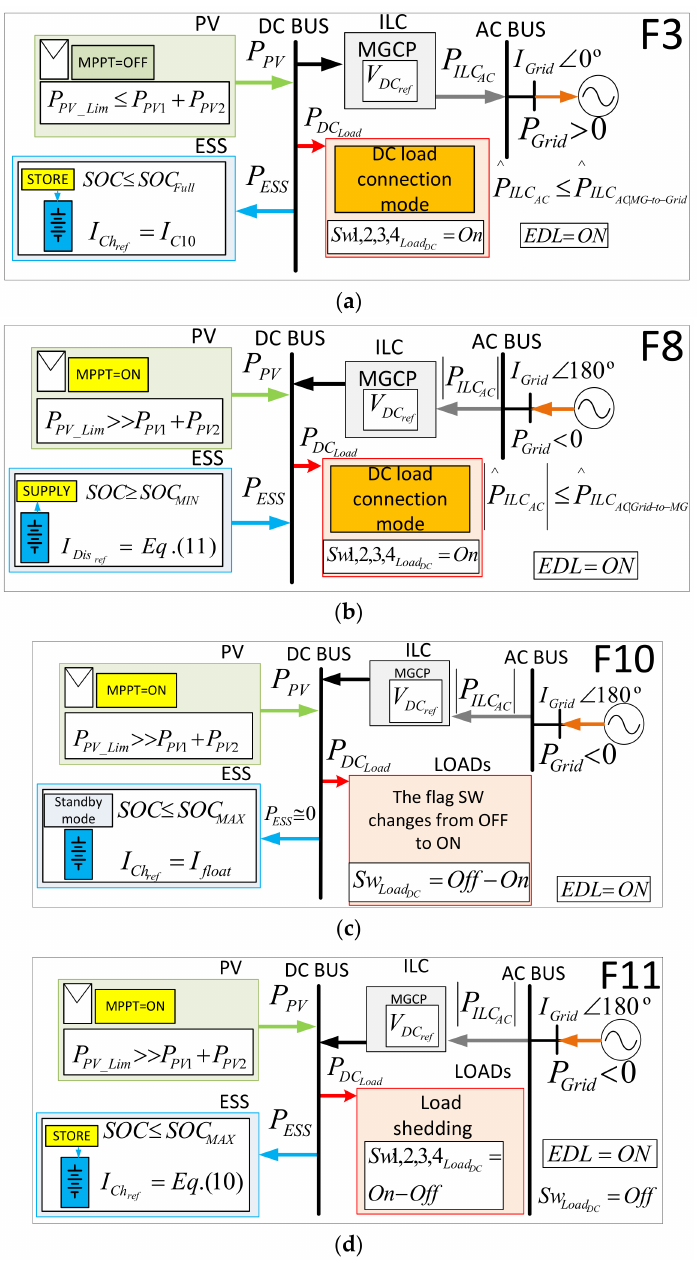
Figure 3. Power dispatch inside the MG after applying the operation functions: ( a ) F3 ; ( b ) F8 ; ( c ) F10 and ( d ) F11